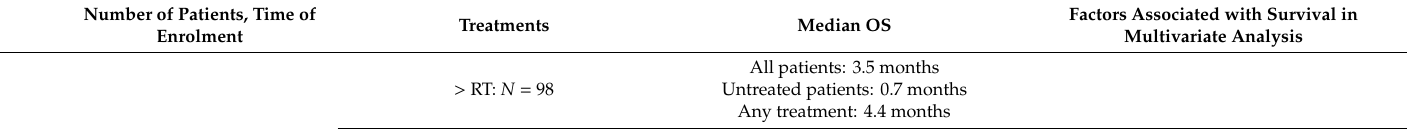
Table 4. Previous studies evaluating melanoma patients with leptomeningeal